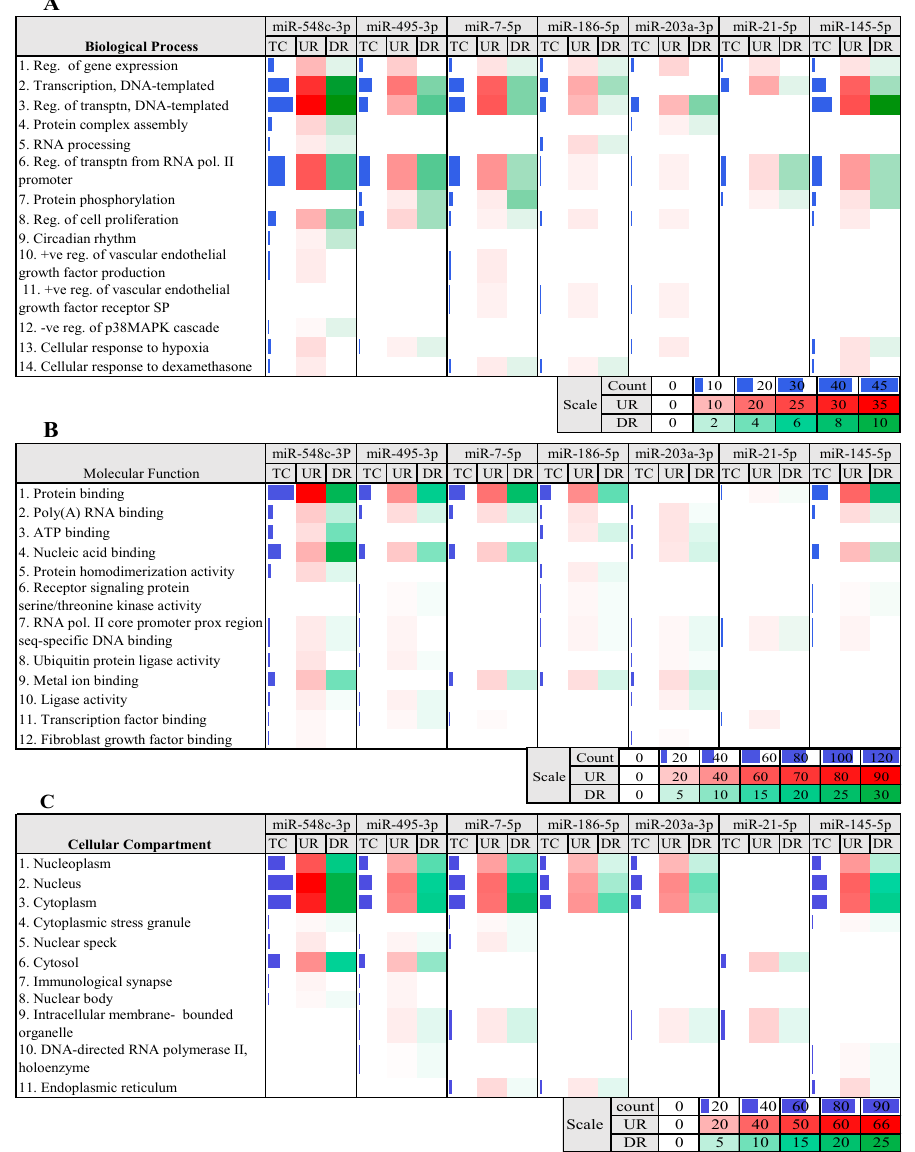
Figure 5. Functional enrichment analyses of miR-DEGs. ( A ): Biological processes associated with miR-DEGs, ( B ): Molecular functions associated with miR-DEGs, ( C ): Cellular compartments of the miR-DEGs. Color intensities show the variation in expression. DR: down-regulated genes, UR: up- regulated genes, Pol II: polymerase II, Seq: sequence, Reg: regulation, +ve: positive, − ve: negative